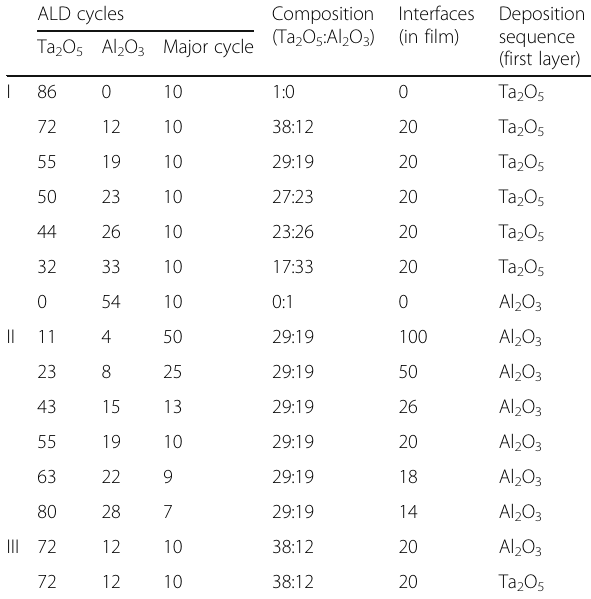
Table 1 The experimental design for studying the effects of composition, interface, and deposition sequence on electrical properties ALD cycles